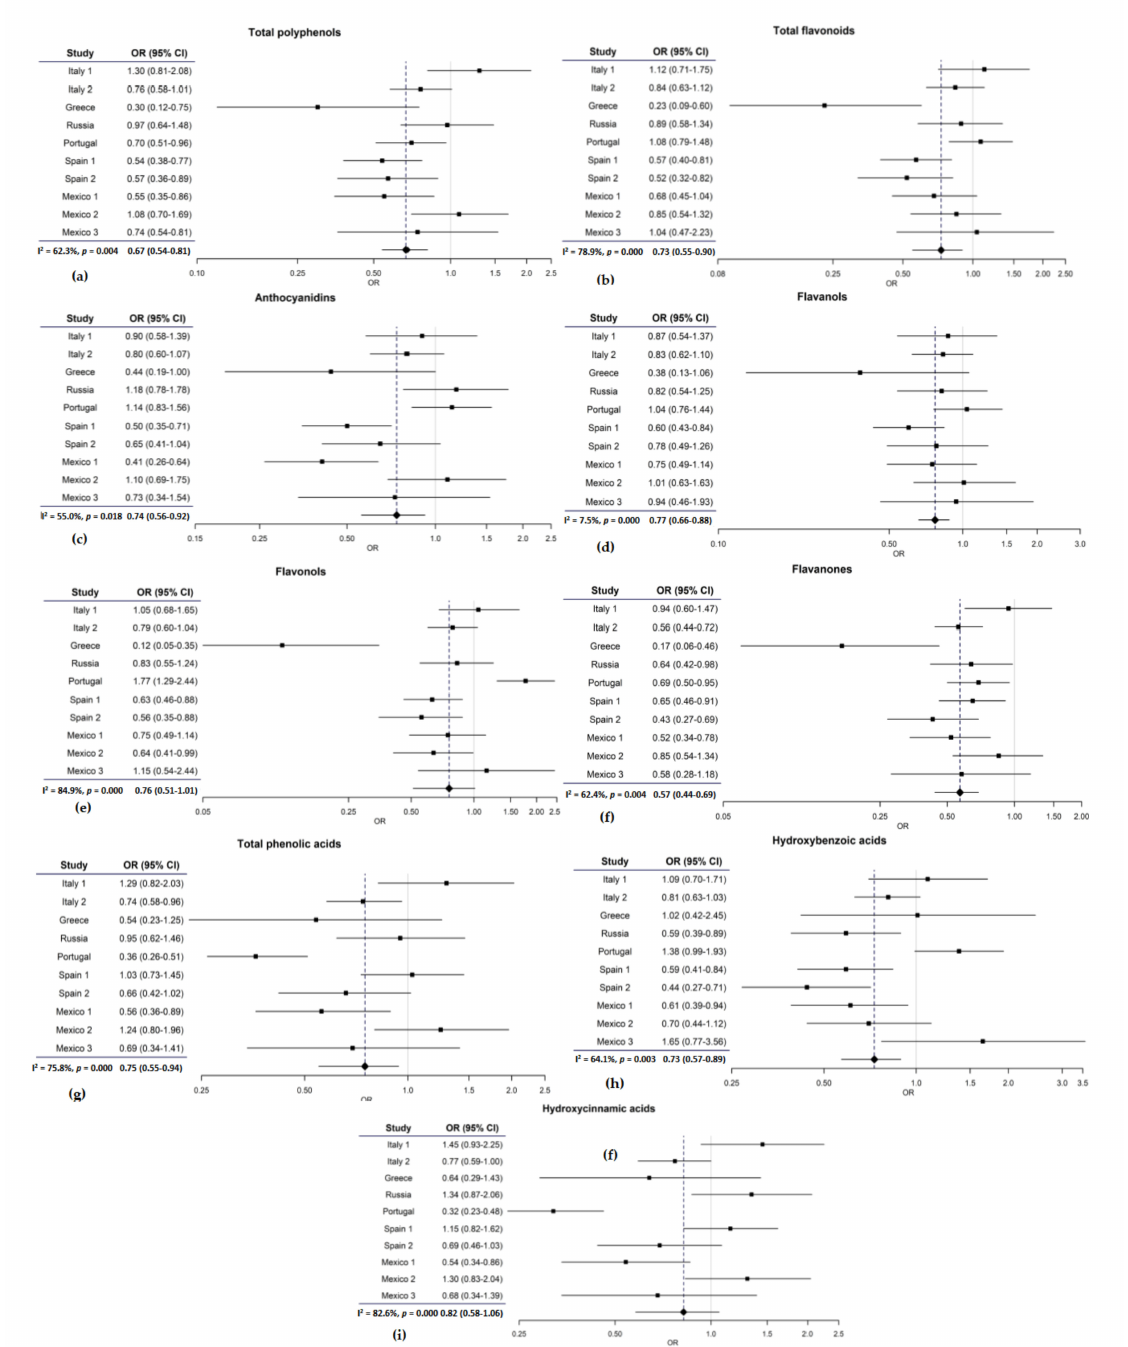
Figure 1. Study specific and pooled odds ratios (OR) and their 95% confidence intervals (CI) for quartile 4 vs. quartile 1 of polyphenol intake; ( a ) pooled analysis of polyphenols; ( b ) pooled analysis of flavonoids; ( c ) pooled analysis of anthocyanidins; ( d ) pooled analysis of flavanols; ( e ) pooled analysis of flavonols; ( f ) pooled analysis of flavanones; ( g ) pooled analysis of phenolic acids; ( h ) pooled analysis of hydroxybenzoic acids; ( i ) pooled analysis of hydroxycinnamic